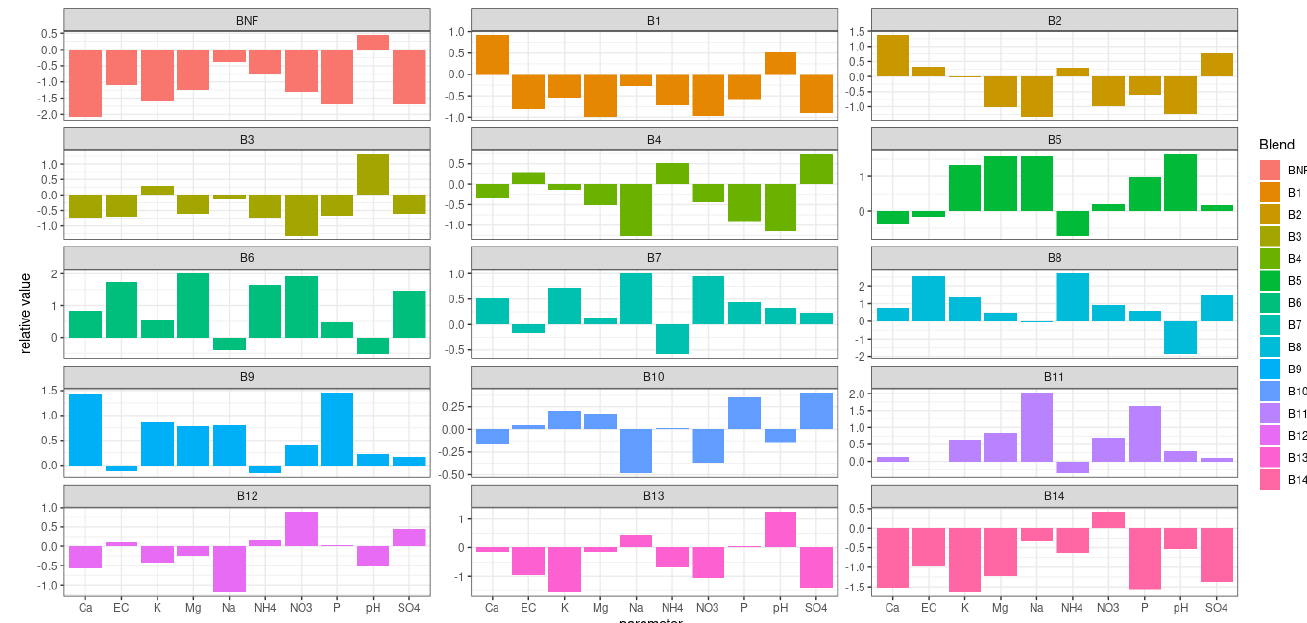
Data of the nutrient concentration in each blend underwent a ‘z-transformation’ to better visualise the nutrient concentration range in each blend. Values near 0 are average, +2 is exceptionally high, –2 is extremely low compared to the others (Figure 1).